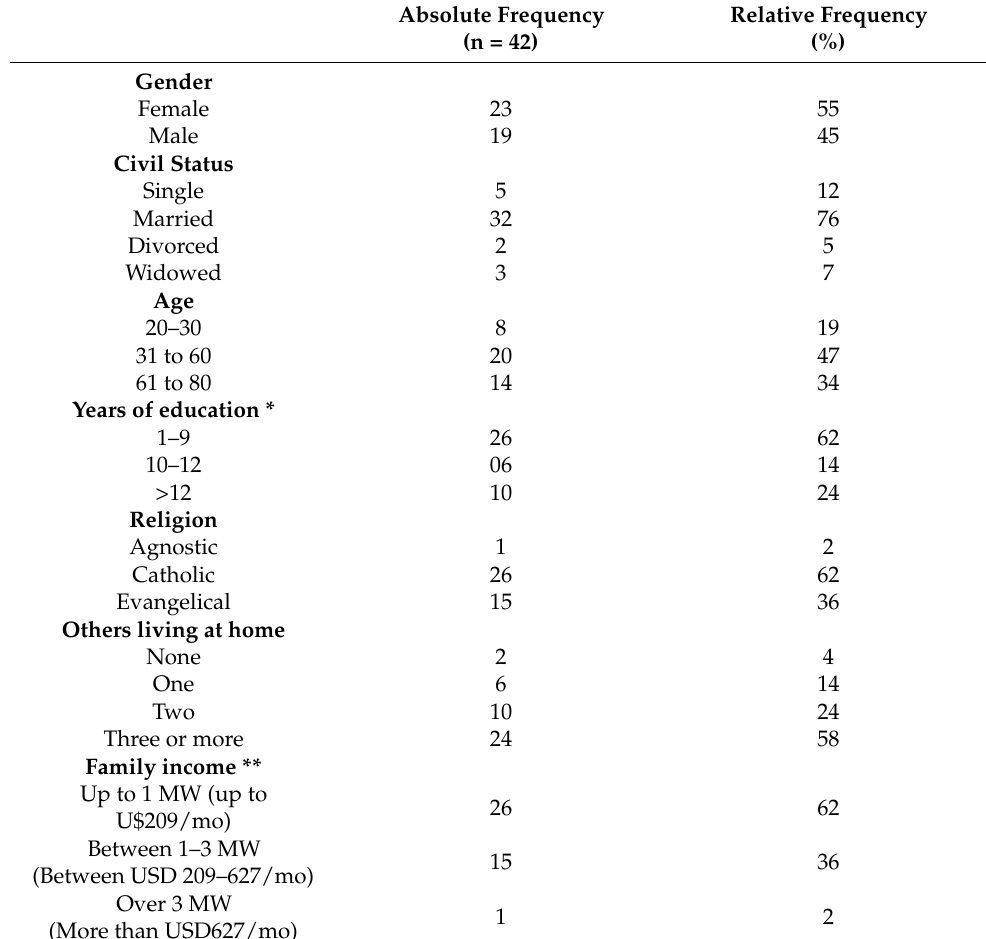
Table 1. Sociodemographic profile of the